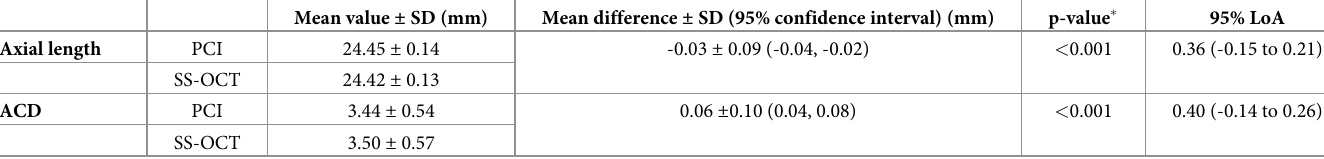
Table 1. Mean value, mean difference and 95% limit of agreement of axial length in 175 eyes and anterior chamber depth in 104 eyes readings of the two biometry